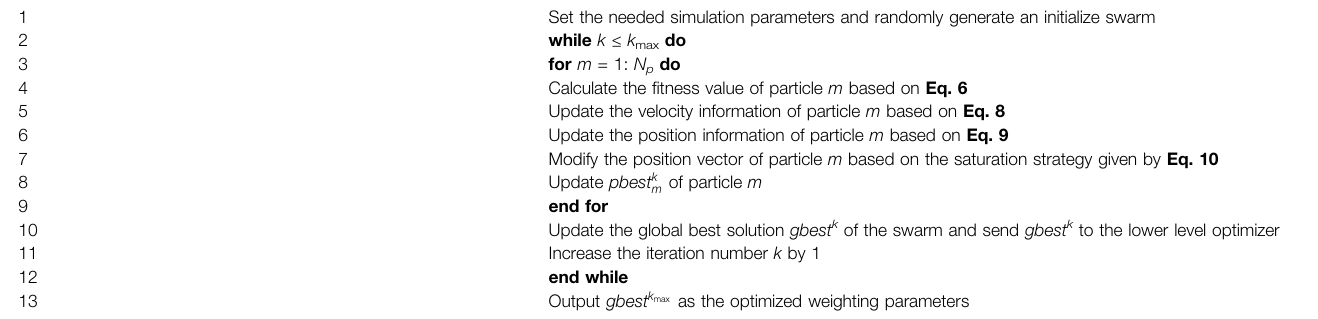
TABLE 1 | Algorithmic steps of using PSO to solve the upper level of human lifting motion. 1 Set the needed simulation parameters and randomly generate an initialize swarm 2 while k ≤ k max do 3 for m = 1: N p do 4 Calculate the fi tness value of particle m based on Eq. 6 5 Update the velocity information of particle m based on Eq. 8